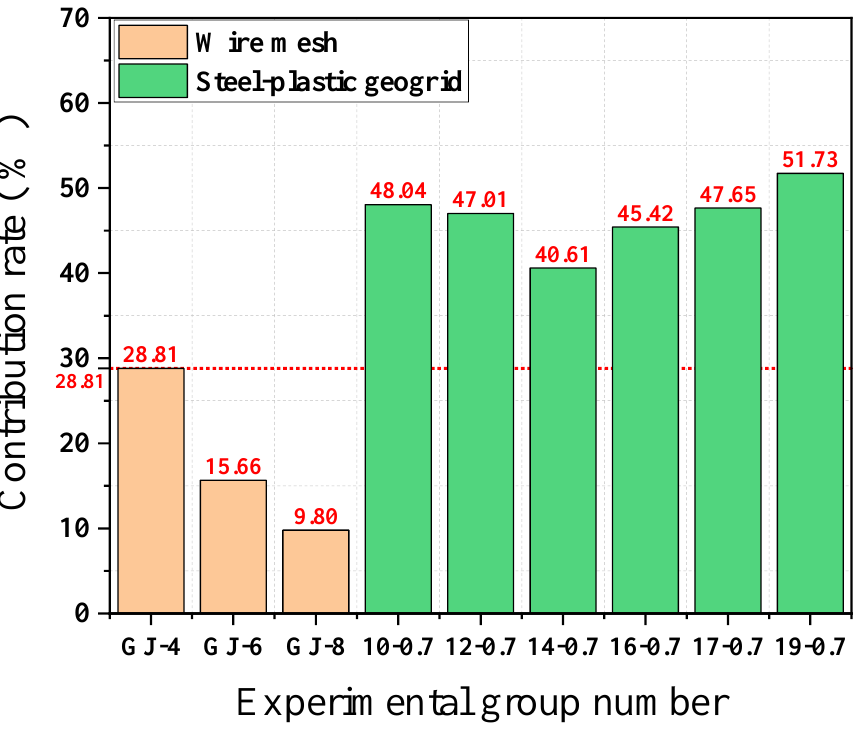
Figure 11. Contribution of mesh wire carrying capacity.